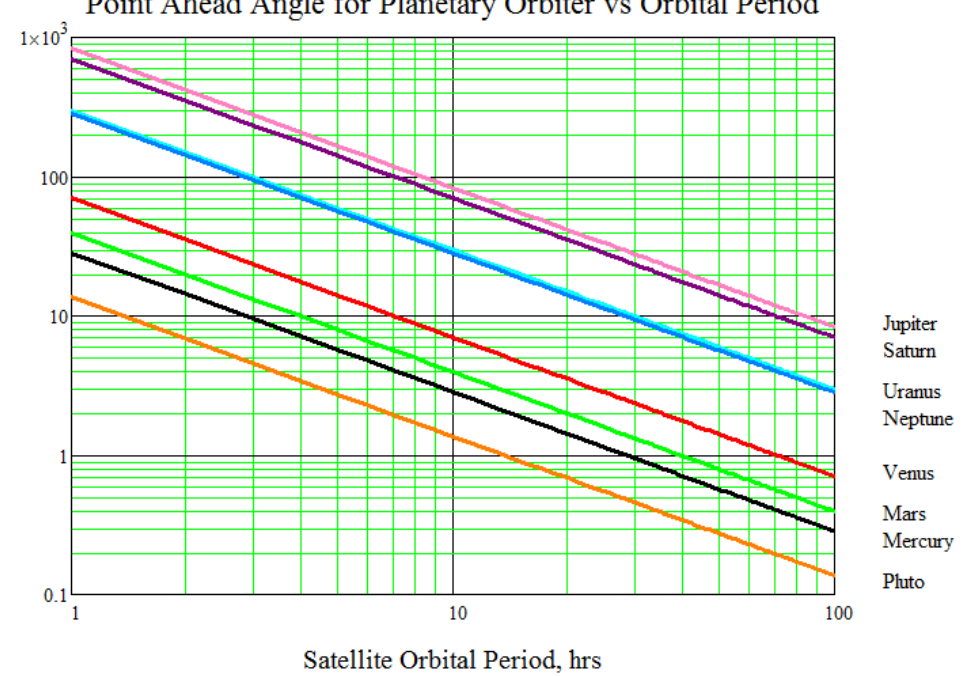
Figure 7. Additional point ahead angles required to compensate for the two-way light transit times between the Earth and a terminal in a polar orbit about the subject planet and in a plane approximately perpendicular to the Earth line-of-sight as a function of the orbital period. Such an orbit would: (1) provide access to the entire surface and atmosphere of the planet under study; (2) greatly reduce the angular uncertainty of the terminal location during initial acquisition; and, (3) with quasi-parallel orientation of the orbits, provide very long periods of uninterrupted access between the orbiting planetary and Earth communications terminals before orbital orientation adjustments would be required.